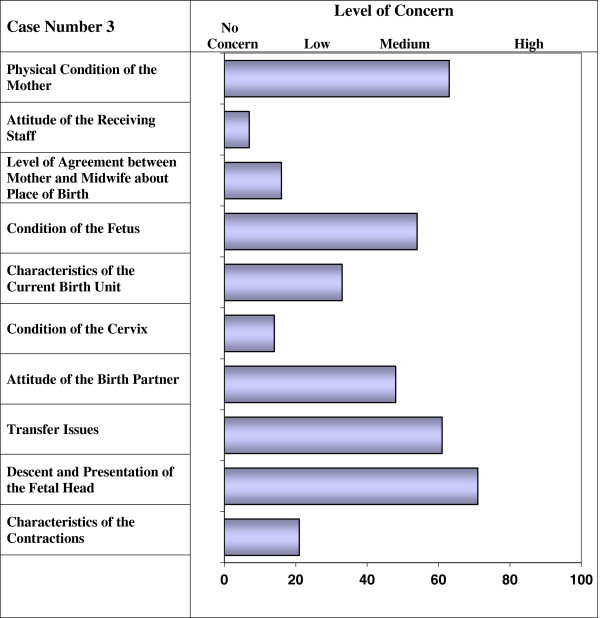
Vignette Example.